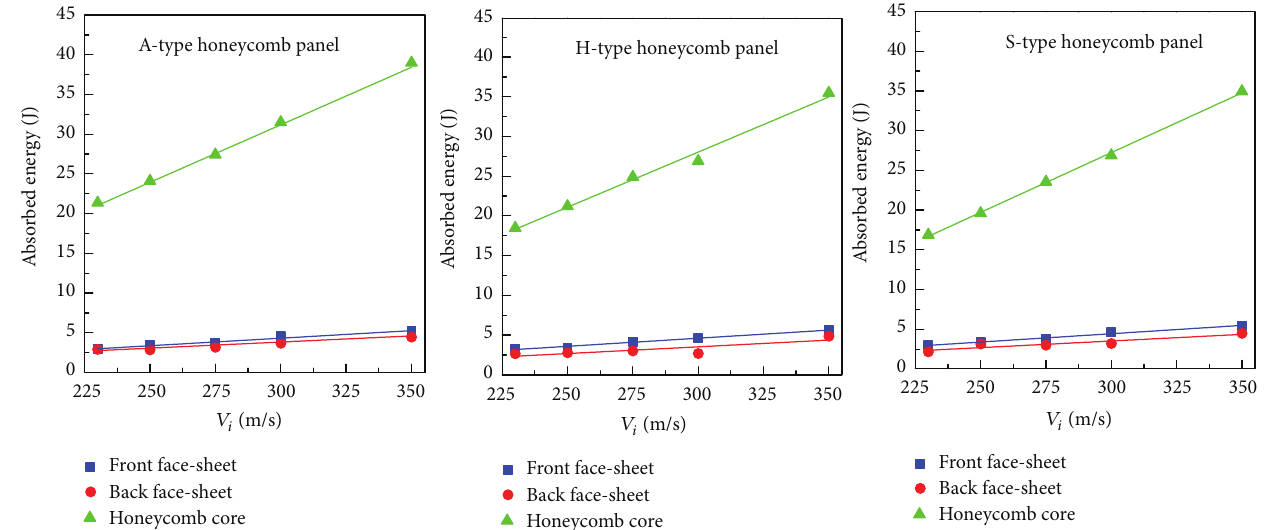
Figure 6: Absorbed energy versus impact velocity for the three types of HSPs.